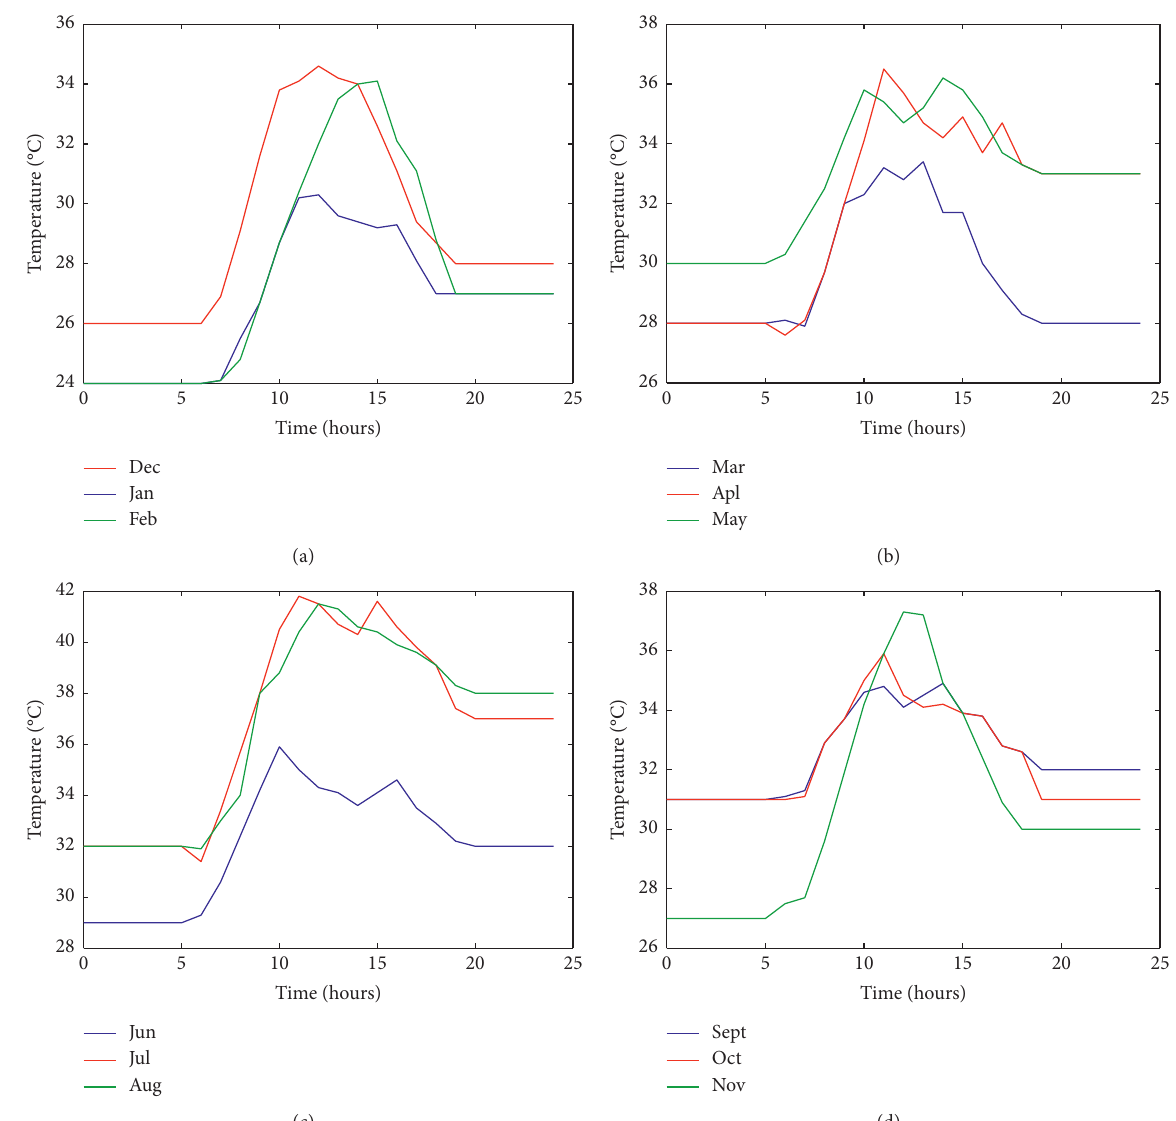
Figure 10: Temperature of typical days for each month and season. (a) Winter, (b) spring, (c) summer, (d) autumn.